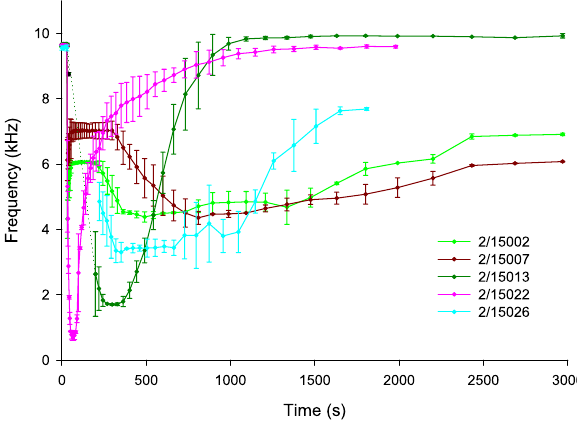
Figure 8. Composite of BARDS profiles of the falsified artesunate